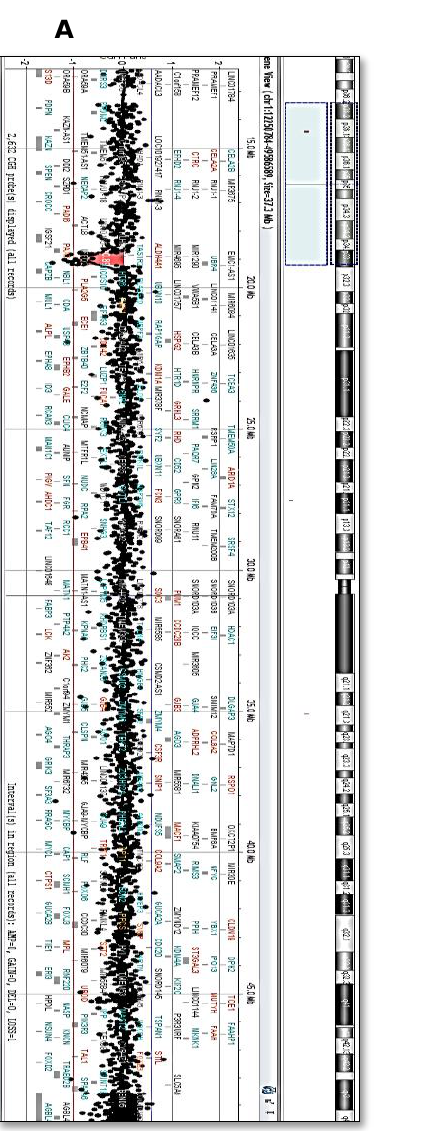
Figure 2. ( A ). CGH array showing an approximately 438 kb deletion in the 1p36.13 region (19085207_19522963) detected in this patient. ( B ). Cytogenomics [GRCh37] showing the TAS1R2, ALDH4A1, and UBR4 genes in the deleted region. ( C ). Parents’ CGH arrays did not show the deletion. The regions of interest in the parents ’ DNA ( C1 ) (mother’s and father’s DNA 1:1 mix) and the patient ’s DNA ( C2 ) are shown for comparison.